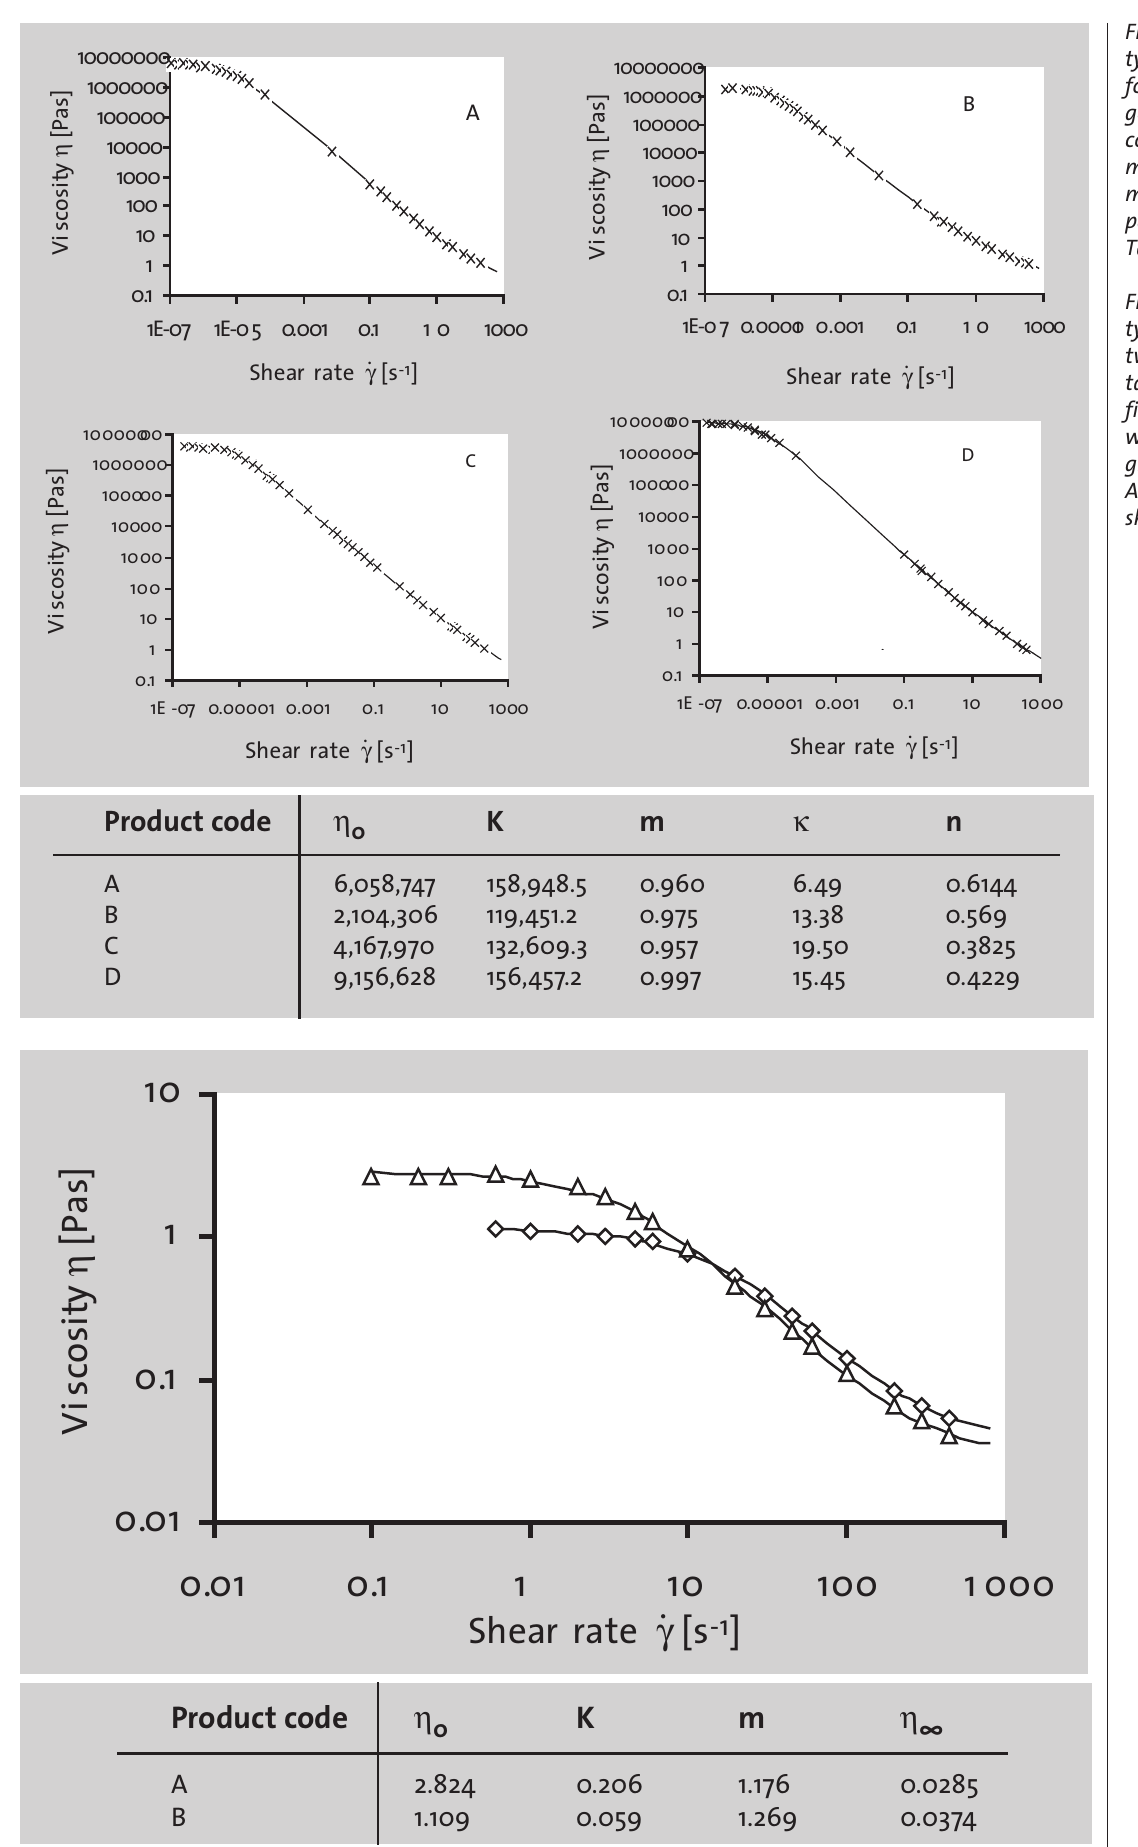
Figure 7 (above): Viscosi- ty/shear-rate curves for four commercial shower gels, fitted to the five- constant simplified Cross model plus power-law model fitted using the parameters given in Table 3. Figure 8 (below): Viscosi- ty/shear-rate curves for two commercial surfac- tant-thickened bleaches fitted to the Cross model, with the parameters given in Table 4 (sample A has the higher low- shear rate